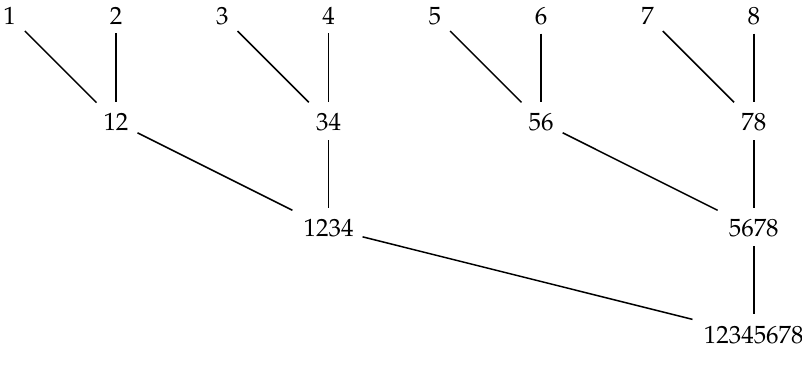
Figure 2. Improved merging